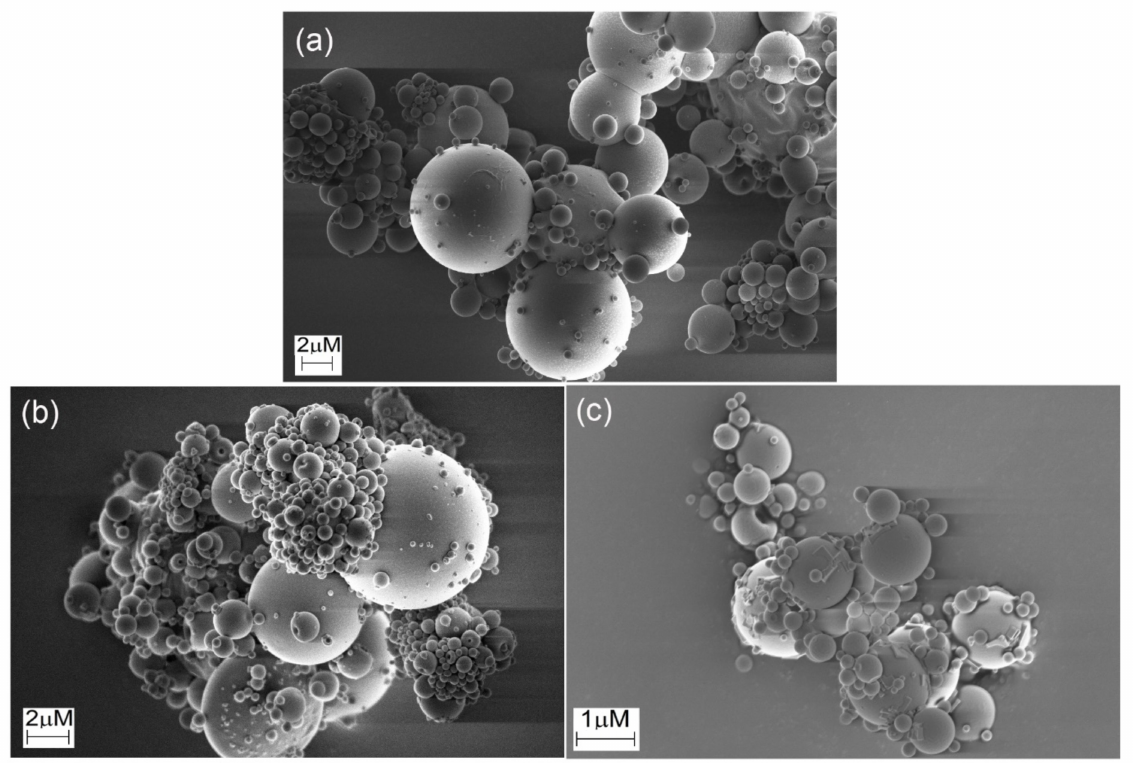
Figure 5. SEM images of microparticles produced by spray drying of ( a ) native HA and HA crosslinked with ( b ) glutaralde- hyde (HAGA) and ( c ) urea